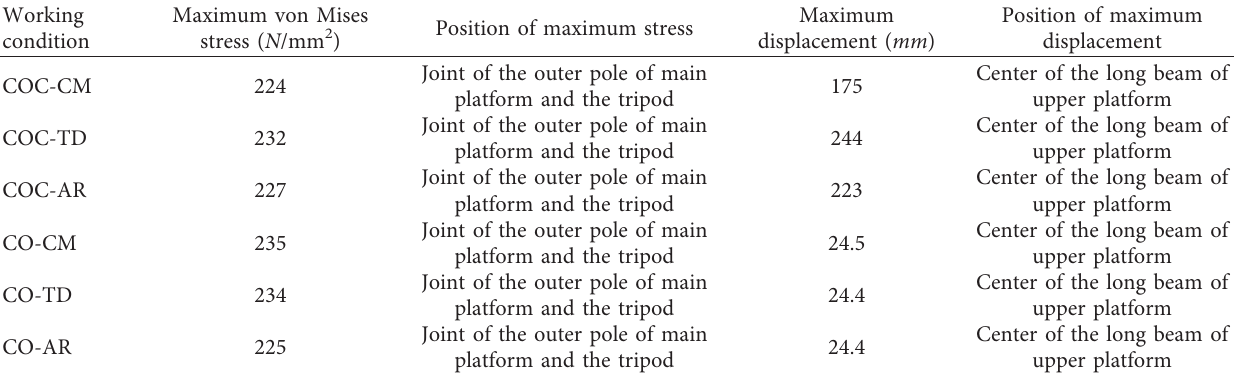
Figure 10: Peak nephogram of climbing formwork under the working condition CO-CM. (a) Peak von Mises stress nephogram (N/m 2 ); (b) peak displacement nephogram (m). MX stands for maximum von Mises stress point and maximum displacement point. MN stands for minimum von Mises stress point and minimum displacement point. Table 8: Structure peak response of climbing formwork under the construction